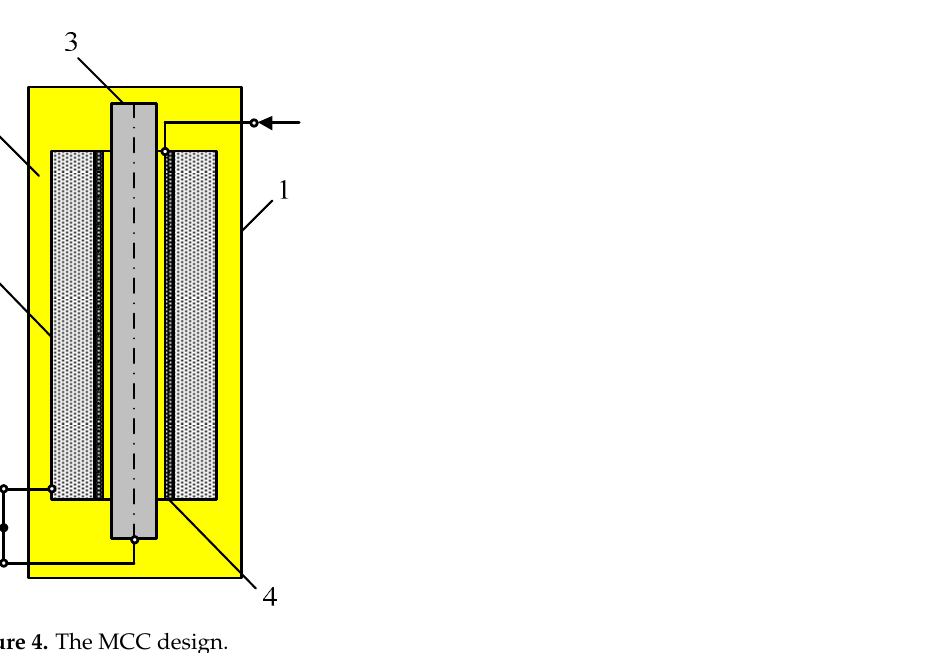
Figure 4. The MCC design.